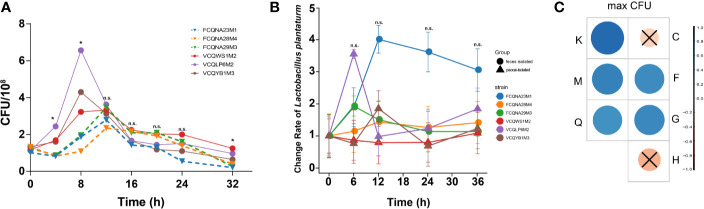
Growth profiles of L. plantarum strains in two media and their associations with genes. (A) Growth profiles of six L. plantarum strains in a paocai diluent. (B) Change rate of the relative abundance of six L. plantarum strains in the simulated intestinal juice. (C) Correlation grid plot for the correlation between maximum CFUs of L. plantarum strains in the simulated intestinal juice and functional genes. Red represents positive correlation; blue represents negative correlation. *represents p < 0.05; n.s. represents p > 0.05; × represents p > 0.05.